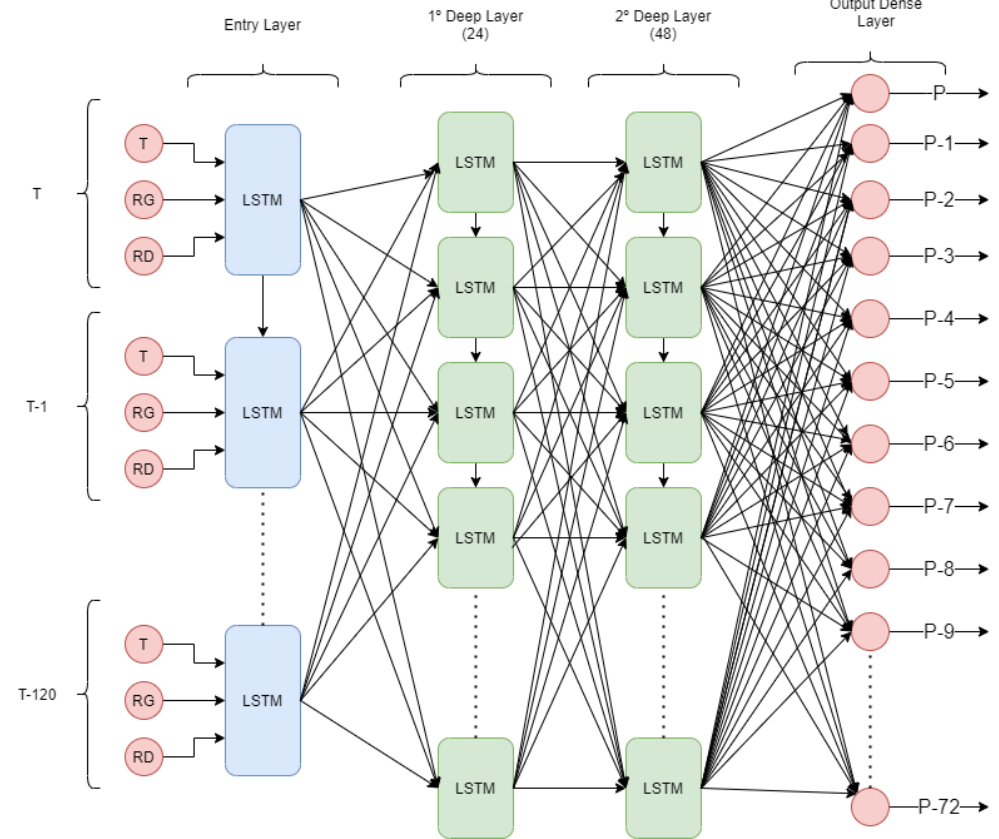
Figure 2. Outline of the proposed LSTM